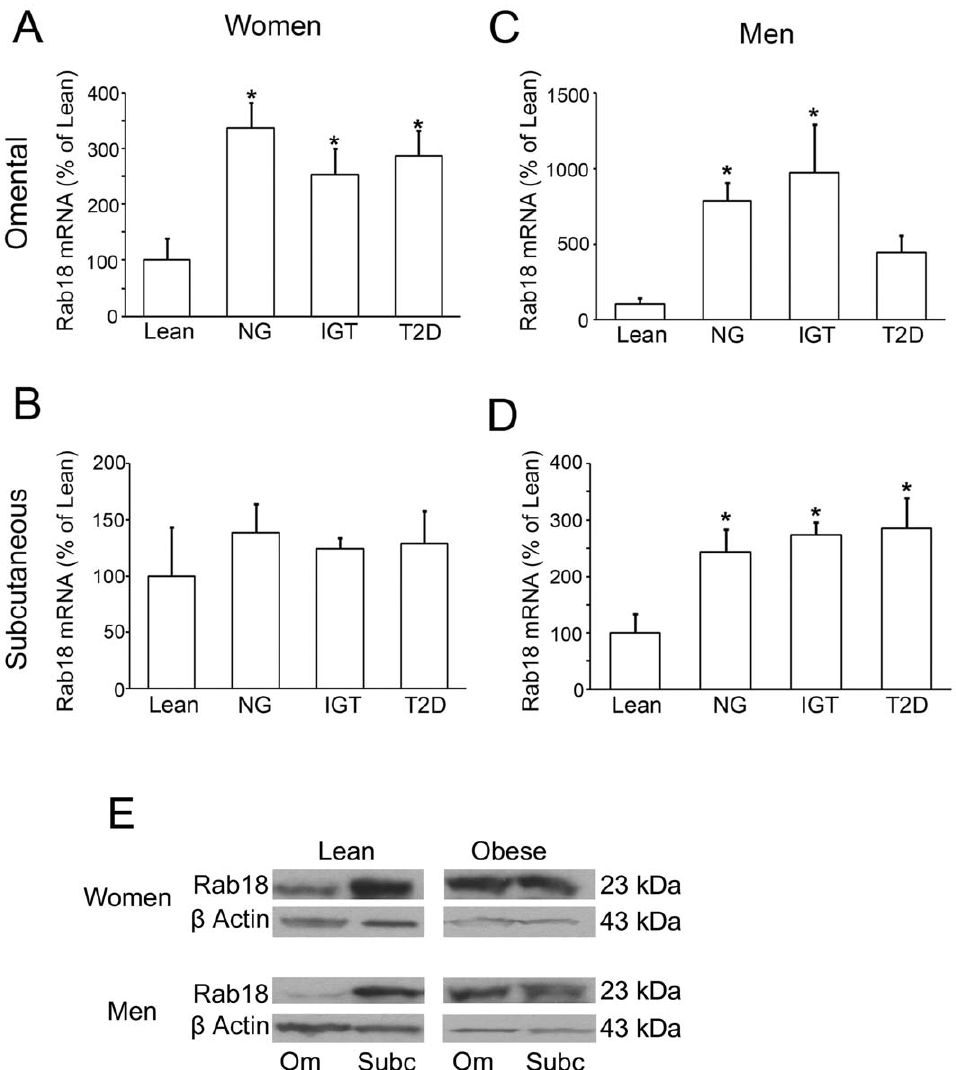
Figure 8. Assessment of Rab18 expression levels in human adipose tissue in relation to obesity and insulin resistance. Omental and subcutaneous adipose tissue samples were obtained from the abdominal region of women (A and B) and men (C and D) with different degrees of obesity and/or insulin-resistance: lean, obese normoglycemic (NG), obese with impaired glucose tolerance (IGT) and obese type 2 diabetic (T2D) patients. After removal, tissue samples were processed for total RNA extraction. Rab18 expression was evaluated by quantitative RT-PCR using specific primers for human Rab18. The expression of human 18S rRNA in each sample was evaluated as an internal housekeeping gene. Absolute cDNA copy number for lean patients were 2.1 6 10 5 6 1.7 6 10 5 Rab18 copies and 6.6 6 10 10 6 5.5 6 10 10 18S copies in omental fat from women, 5.9 6 10 4 6 3.1 6 10 4 Rab18 copies and 5.7 6 10 10 6 1.5 6 10 10 18S copies in omental fat from men, 4.9 6 10 4 6 3.2 6 10 4 Rab18 copies and 1.1 6 10 10 6 6.9 6 10 9 18S copies in subcutaneous fat from women, and 5.2 6 10 4 6 2.0 6 10 4 Rab18 copies and 2.8 6 10 10 6 1.3 6 10 9 18S copies in subcutaneous fat from men. *, P , 0.05 vs. lean subjects. (E) Rab18 protein content in omental and subcutaneous adipose tissue samples from lean and obese women and men. In each blot, the b -actin immunosignal from the same sample was used as internal